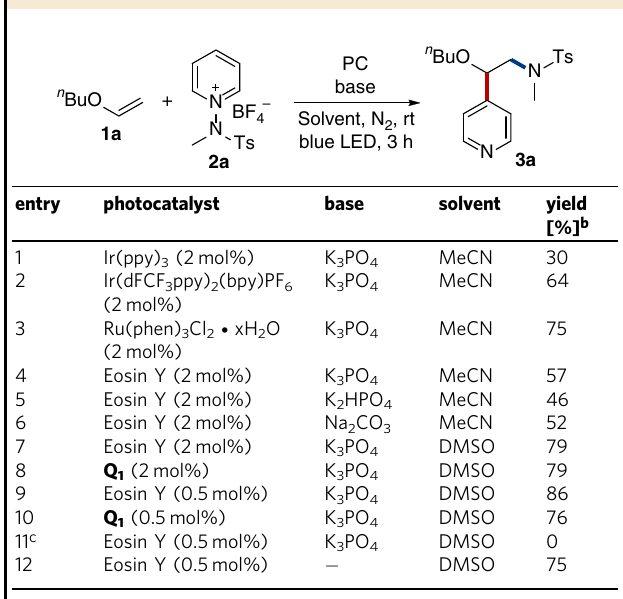
Table 1 Optimization of Reaction Conditions